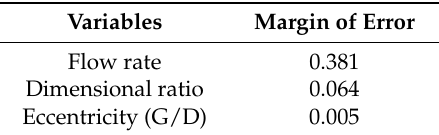
Table 5. Margins of error of parameters.